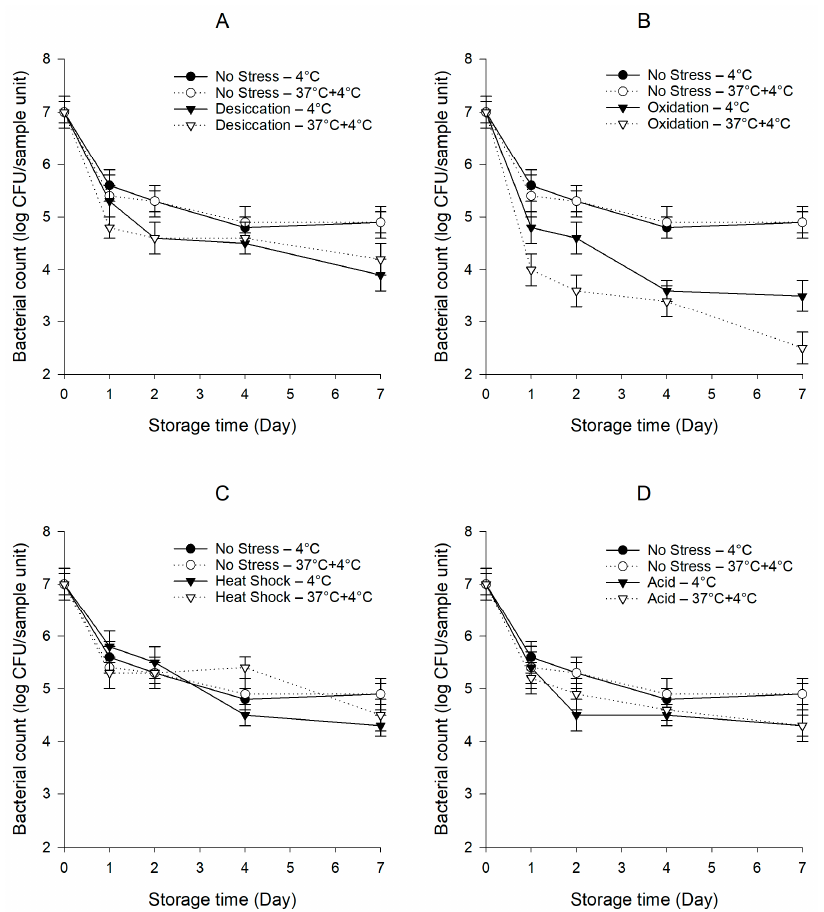
Figure 2. Persistence of S. Typhimurium ATCC 14028 wild type and ∆ rpoS mutant on baby spinach under cold and temperature abuse conditions with or without prior exposure to sub-lethal desiccation ( A ), oxidation ( B ), heat shock ( C ), and acid ( D ) stresses. Error bars represent standard deviations ( n = 3).